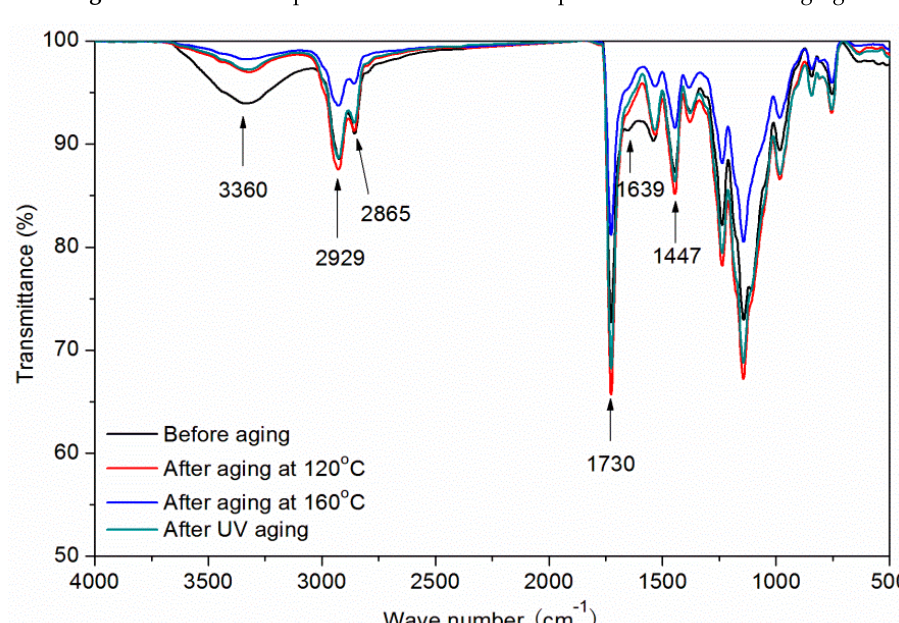
Figure 16. FTIR of the paint film with microcapsules in primer before and after aging.